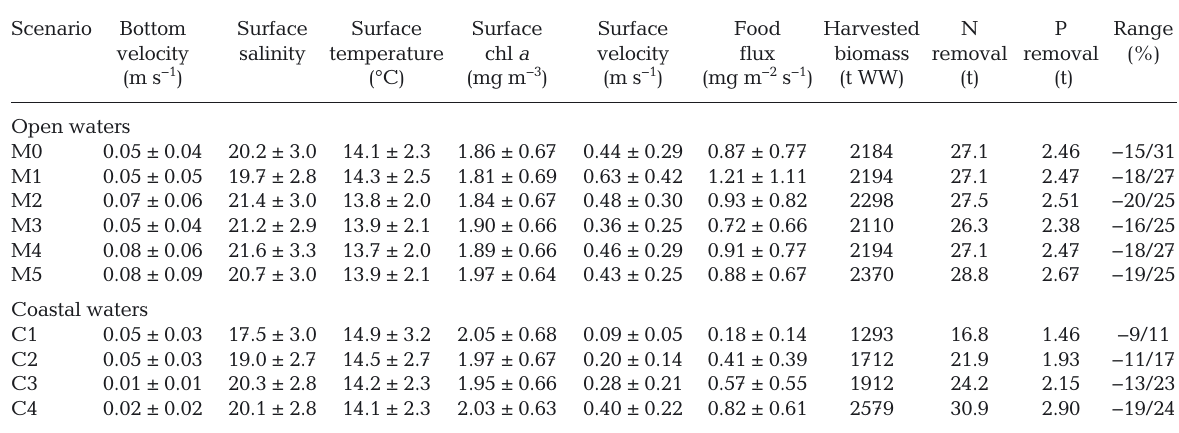
Table 2. Overview of mussel farm locations, means ± SD of bottom velocity and surface environmental conditions (July to No- vember), harvested mussel biomass and N and P removal by harvest on 1 December in the scenarios (farm size = 36 ha). The last column shows the potential range (minimum/maximum difference from the mean) of harvested biomass and N and P removal. WW: wet